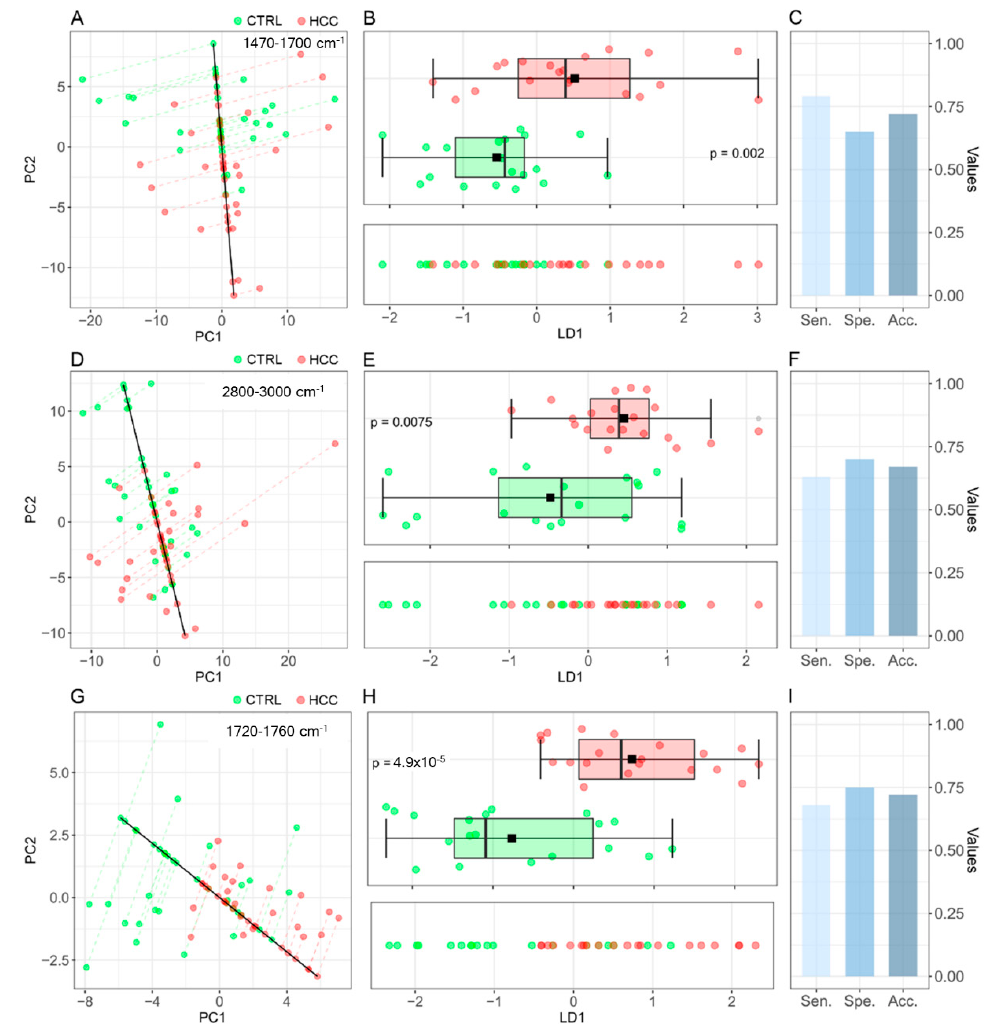
Figure 5. ( A ) Projections of the spectral data in the PC1–PC2 plane for the region enclosed between 1470–1700 cm − 1 , together with the LD1 line (black continuous line), which maximizes the separation between controls (green points) and HCC patients (red points). ( B ) LD1 discriminant scores from the region enclosed between 1470 and 1700 cm − 1 are reported in the lower panel. The presence of statistically significant difference between the LD1 scores of the two groups is supported by a box- plot analysis (upper panel). ( C ) The PCA-LDA (1470–1700 cm − 1 ) classification performances are re- ported in terms of sensitivity, sensibility, and accuracy. ( D – F ) The same analyses were performed for the region enclosed between 2800–3000 cm − 1 and ( G – I ) the region enclosed between 1720–1760 cm − 1 . 3.3. A Combined Spectral Biomarker for HCC Diagnosis In Figure 6, we evaluate the classification performance of each of the spectral bi- omarkers highlighted in Figures 4 and 5 using receiving operator characteristics (ROC) curves and computing the corresponding Areas Under the Curve (AUC). The same anal- ysis is carried out for two widely studied HCC circulating markers, namely AFP and